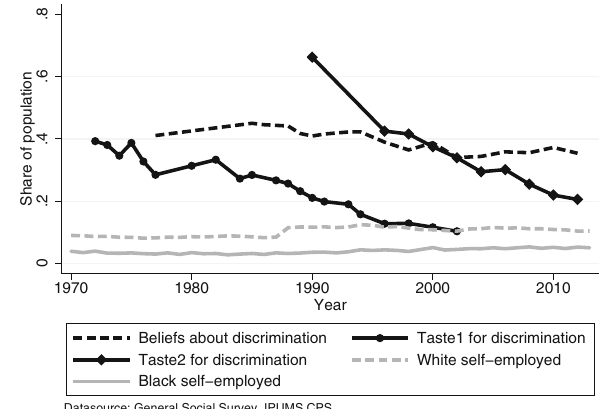
Fig. 1 Self-employment rates by race and beliefs and taste regarding discrimination in the US